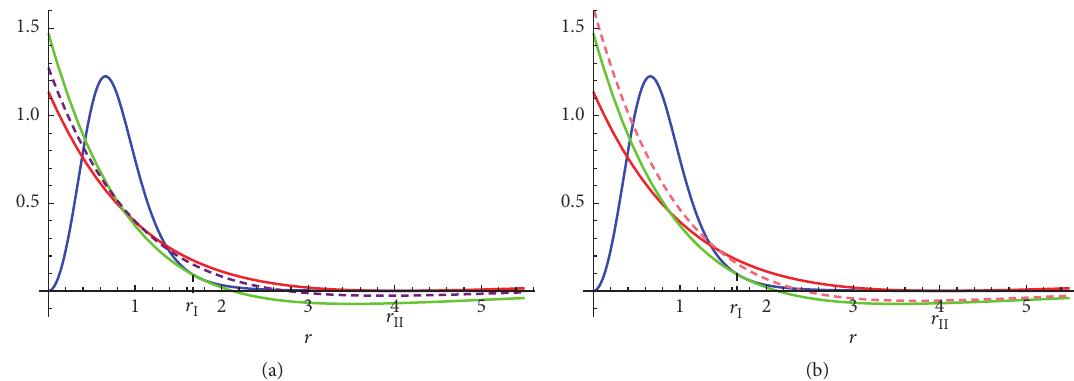
(̃(𝛽/𝑏) exp tan −1 (𝑟/𝑏)) with the different ranges of